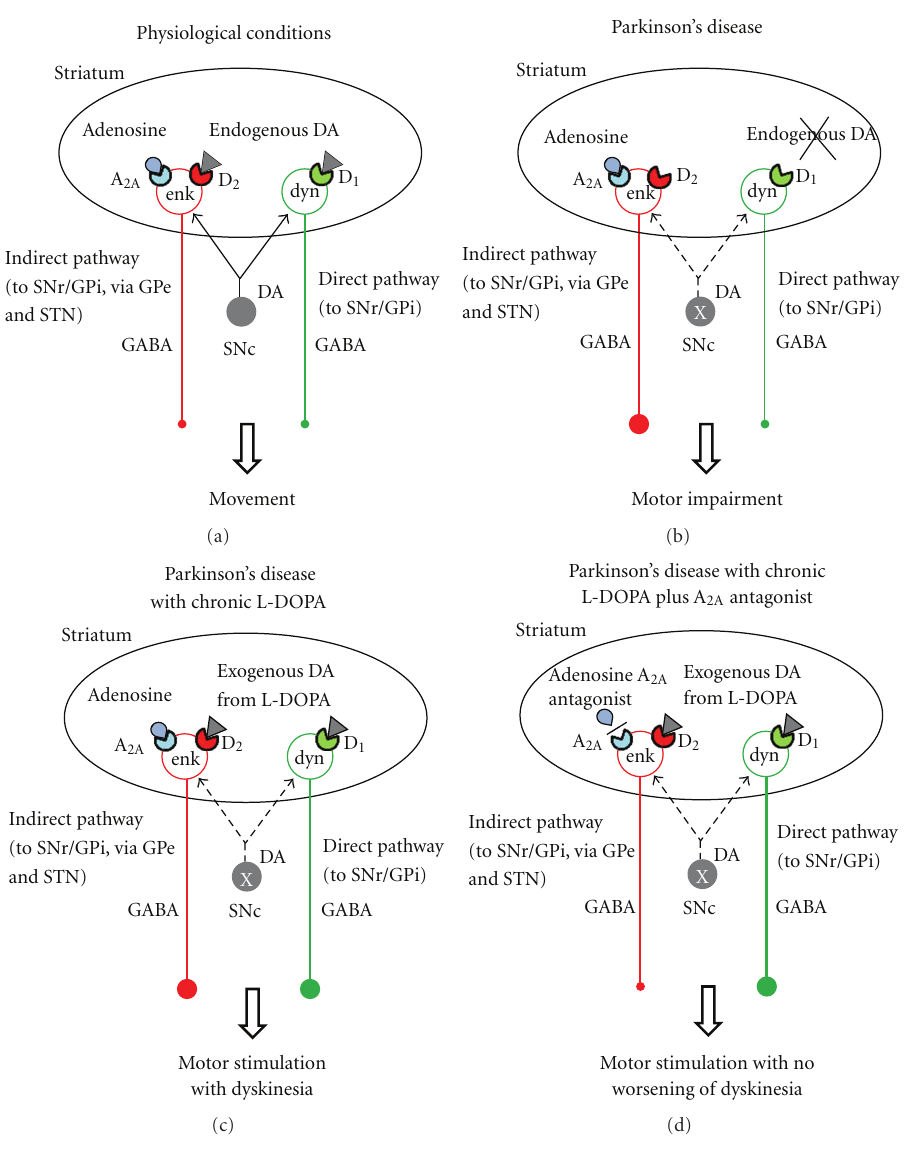
Figure 1: Role of A 2A receptors on modifications in the activity of the striatal e ff erent pathways. Under physiological conditions (a),